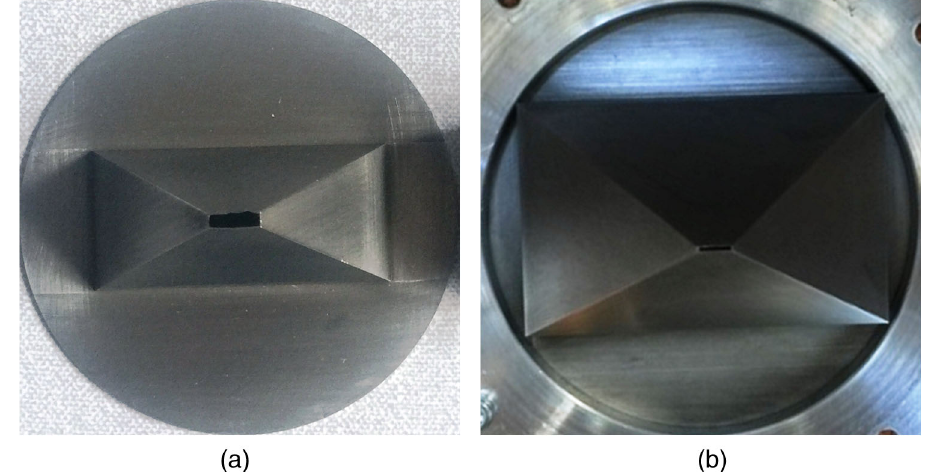
FIG. 4. Picture of the two different sizes of rectangular skimmer: (a) larger slit ( 7 . 2 × 1 . 8 mm 2 ); (b) smaller slit ( 4 . 0 × 0 . 4 mm 2 ).